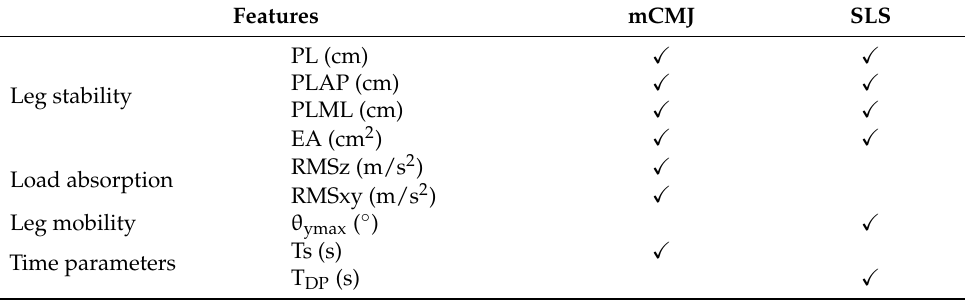
Table 2. Feature selection for both motion